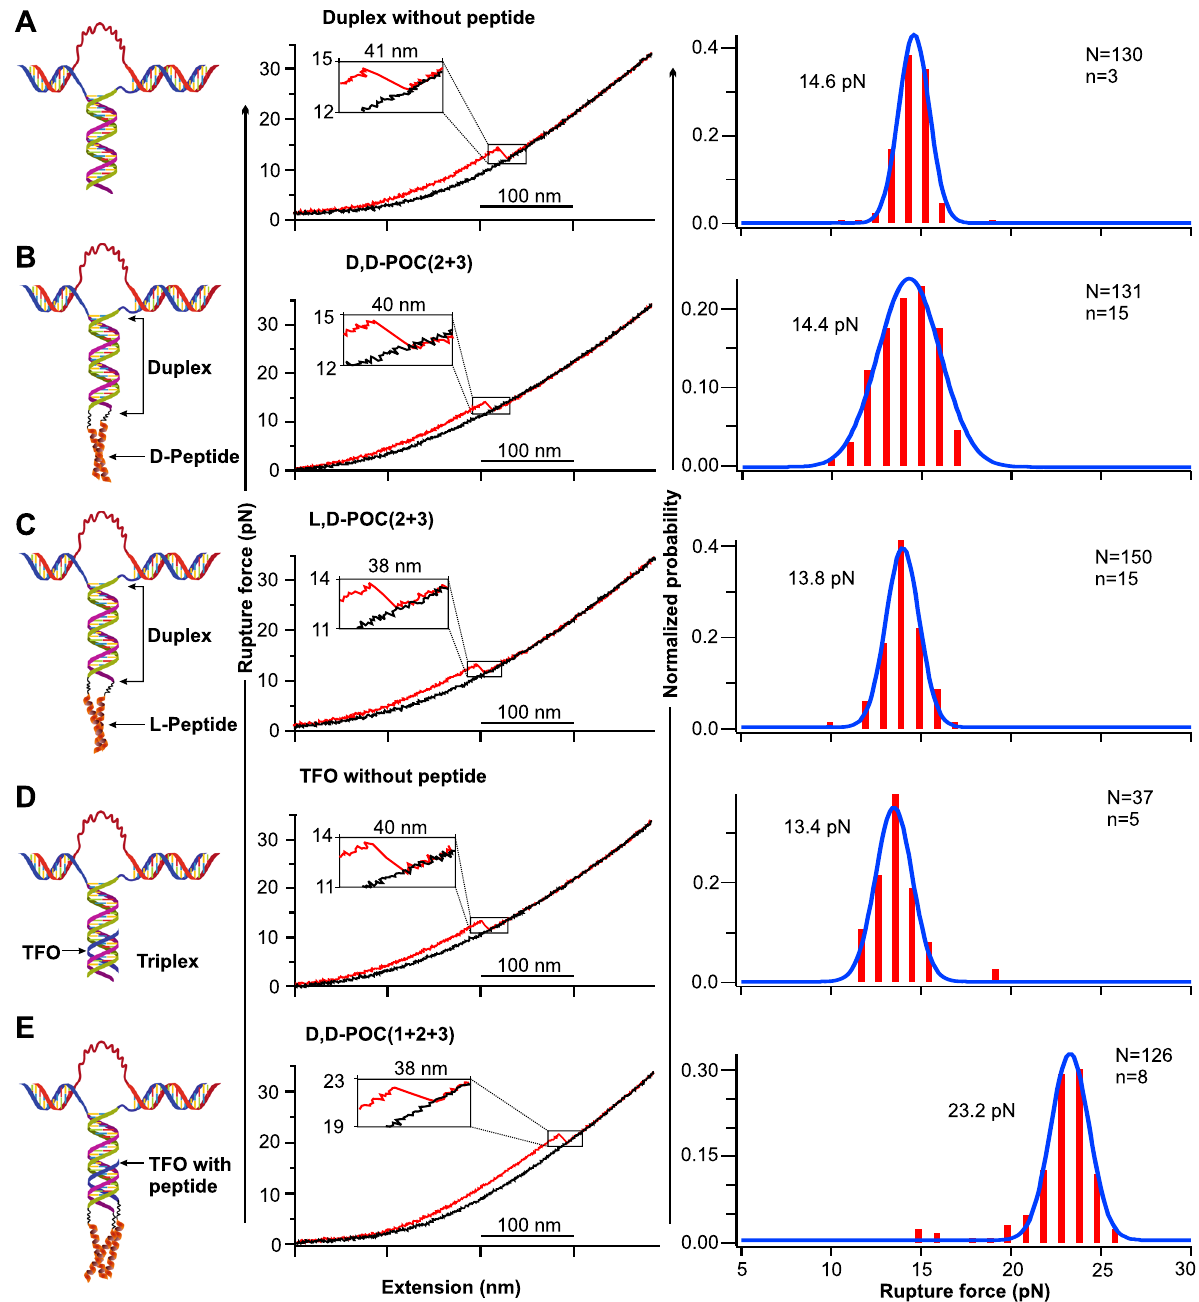
Fig. 3 Effect of TFO or D,D-POC1 on the mechanical stability of the DNA duplex or the chimeric POC duplex D,D-POC(2 + 3). Schematic diagrams, typical force-extension curves and corresponding force histograms of ( A ) DNA duplex control, ( B ) D,D-POC(2 + 3) , ( C ) L,D-POC(2 + 3) , ( D ) DNA triplex control, ( E ) D,D-POC(1 + 2 + 3) . TFO = 3 ′ -TTTTCCCTCTCTCT. Note: red and black traces in a force-extension curve represent stretching and relaxing events, respectively. N and n depict total numbers of features and distinct molecules,